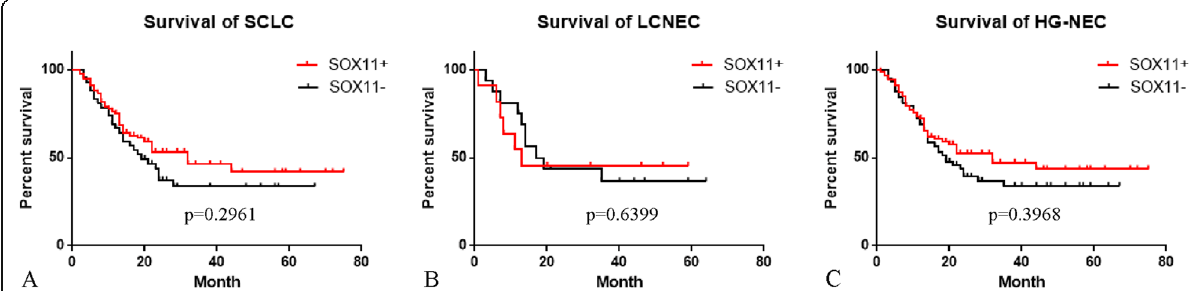
Fig. 3 The overall survival of small cell lung carcinomas (SCLCs), large cell neuroendocrine carcinomas (LCNECs) and high-grade neuroendocrine carcinomas (HG-NECs) between SOX11 positive and negative cases. Kaplan-Meier survival curve showing that SOX11 exhibit no impact on SCLCs, LCNECs and HG-NECs patient survival ( A , B and C , p = 0.2961, 0.6399 and 0.3968,